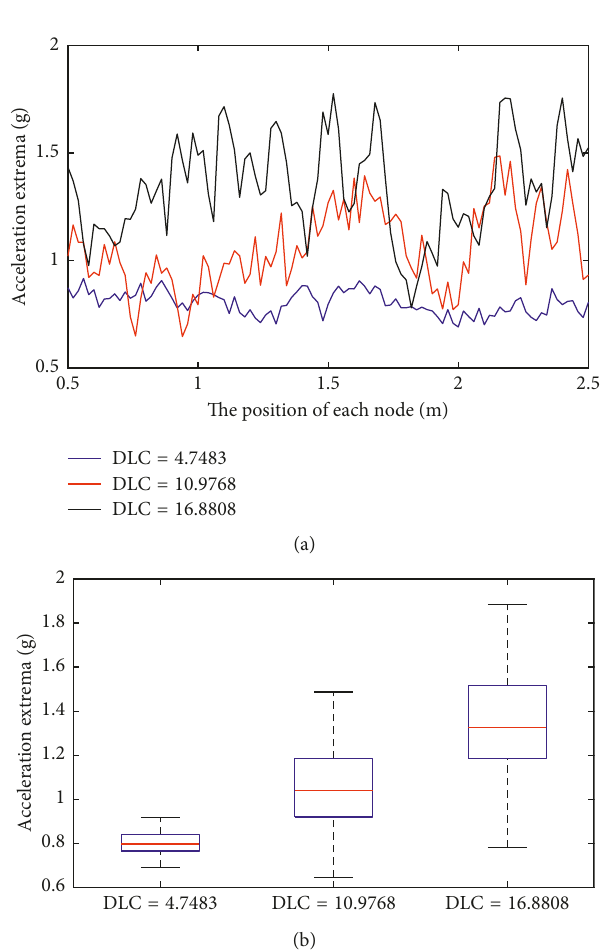
Figure 11: The distribution of acceleration extrema under dif- ferent dynamic load. (a) The acceleration extrema of each node in the monitoring area. (b) The distribution box of acceleration extrema.